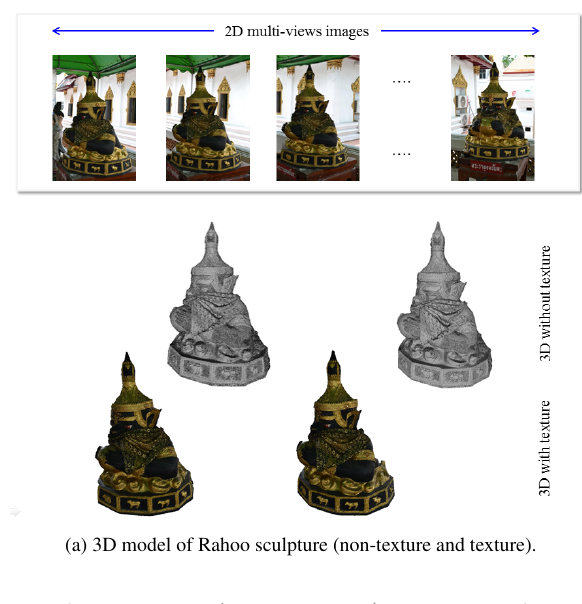
(a) 3D model of Giant (non-texture and texture).